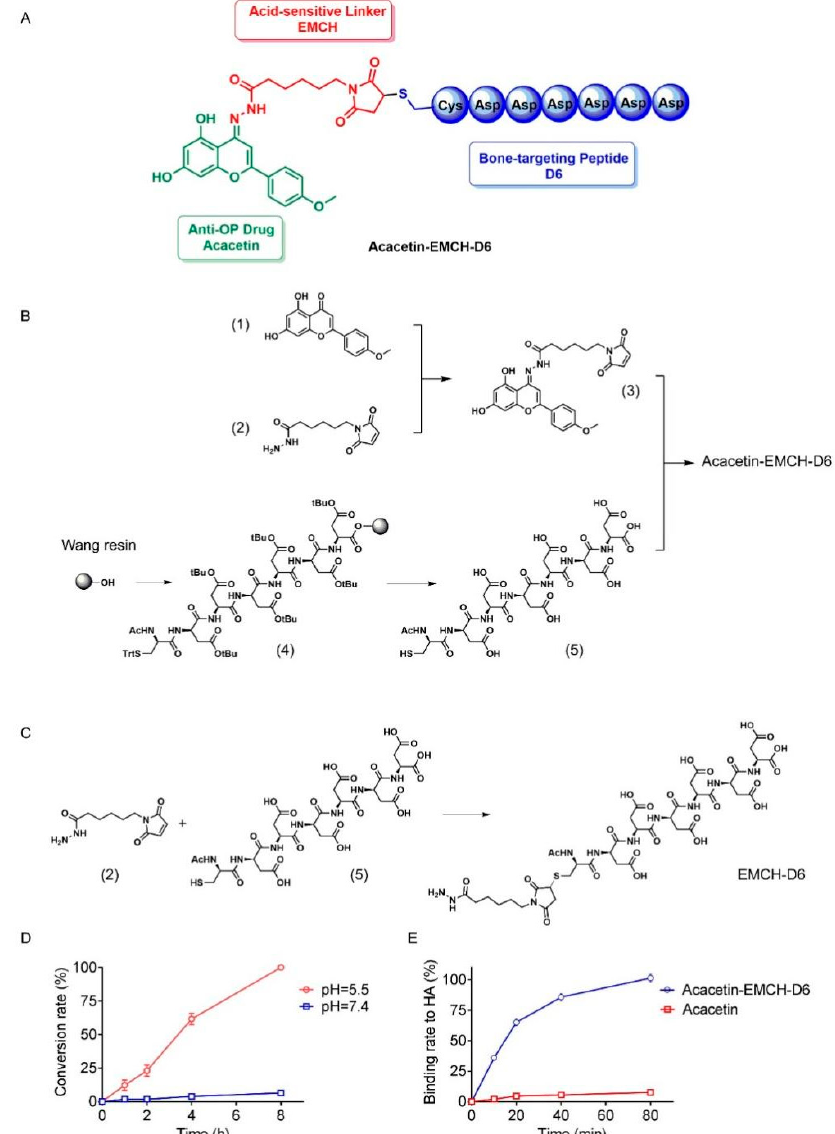
Figure 1. Synthesis and chemical characterization of Acacetin-EMCH-D6. Structure of Acacetin- EMCH-D6 ( A ). Chemical synthesis of the Acacetin-EMCH-D6 ( B ) and EMCH-D6 ( C ). The pH- dependent drug release assay of Acacetin-EMCH-D6 ( D ). Binding of Acacetin-EMCH-D6 and acacetin to hydroxyapatite (HA) ( E ). EMCH, N- ε -maleimidocaproic acid